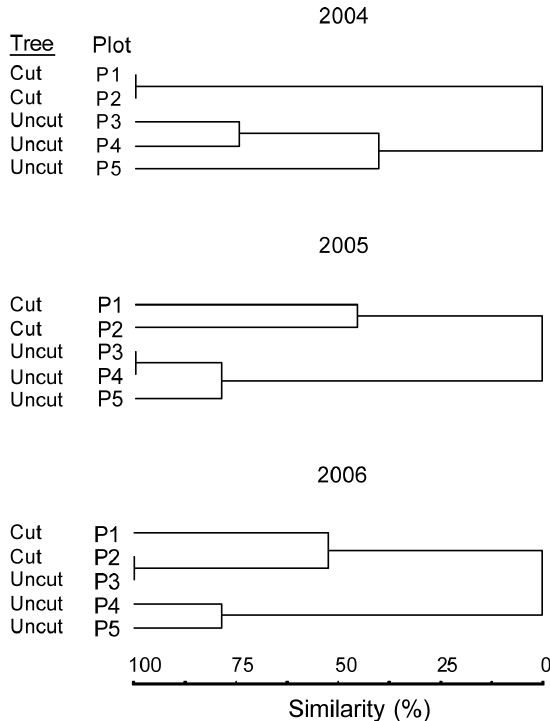
4. Cluster analysis of the ground beetle assemblages in ex- perimental plots performed separately for each year of the experi- mental study (2004, 2005 and 2006). Taxonomic similarity is measured by Sorensen’s relative (quantitative)